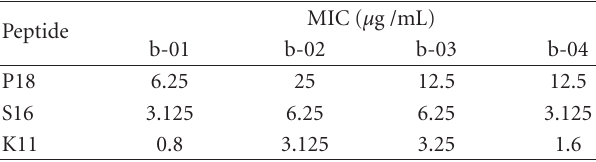
Table 5: MICs of K11 for clinically isolated